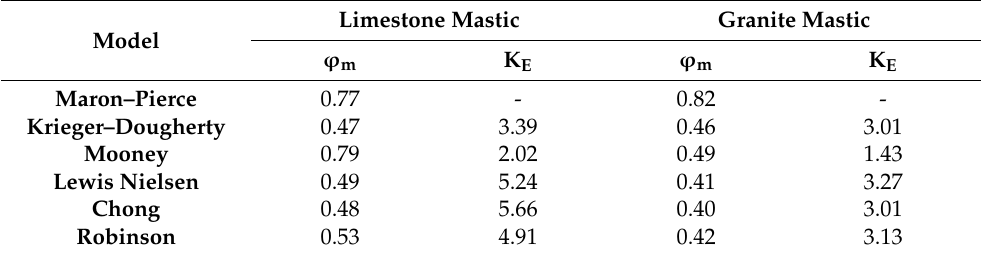
Table 5. Micromechanics models